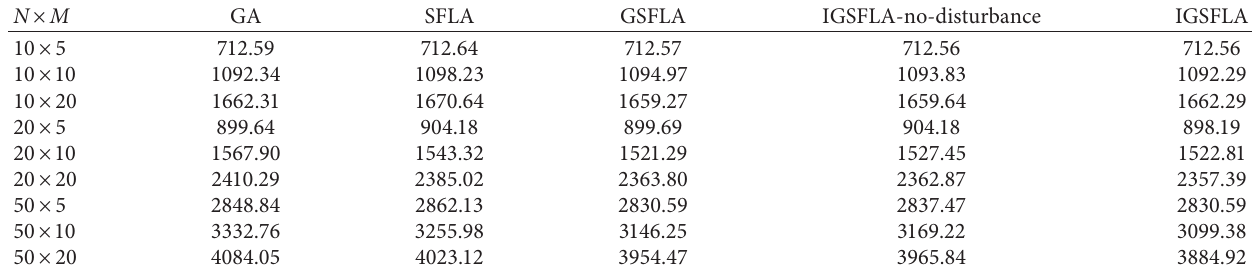
Table 4: The average value of makespan under different algorithms (unit: second). N × M